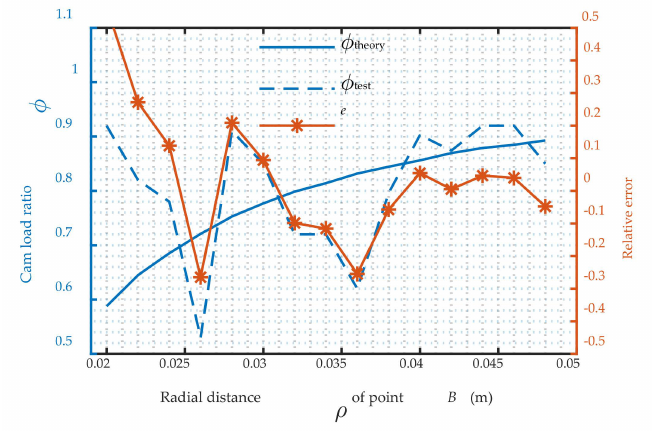
Figure 21. Load ratio φ in configuration I ( AB > OA ).